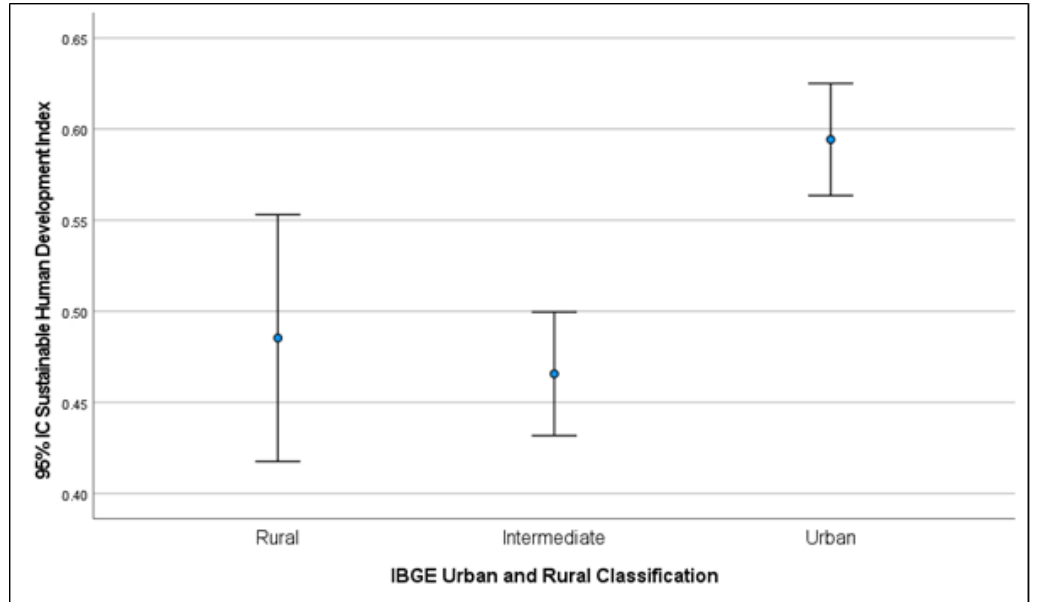
Figure 9. Error bar graph of the municipalities by urbanization degree.